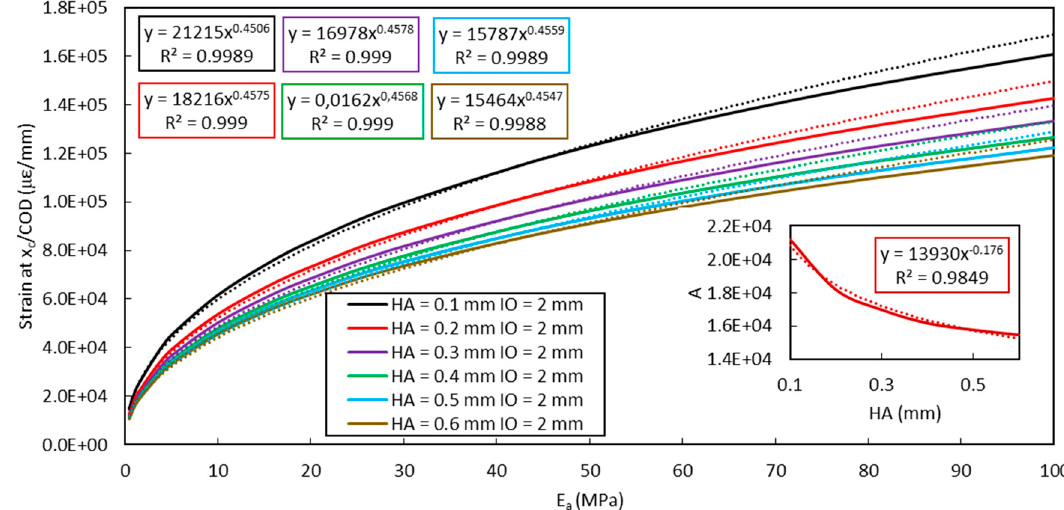
Figure 21. Evolution curves of the shear lag parameter (at x = x c ) versus the adhesive Young’s modulus E a , considering different HA values (FEM simulations in solid lines, exponential fitting in dotted lines). Dependence of parameter A on HA is also displayed as enclosed graph.